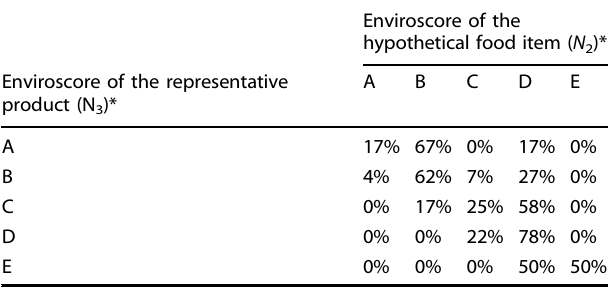
Table 4. Contingency table comparing results of the Enviroscore categorization of the representative products with the Enviroscore results of the hypothetical food item alternatives of